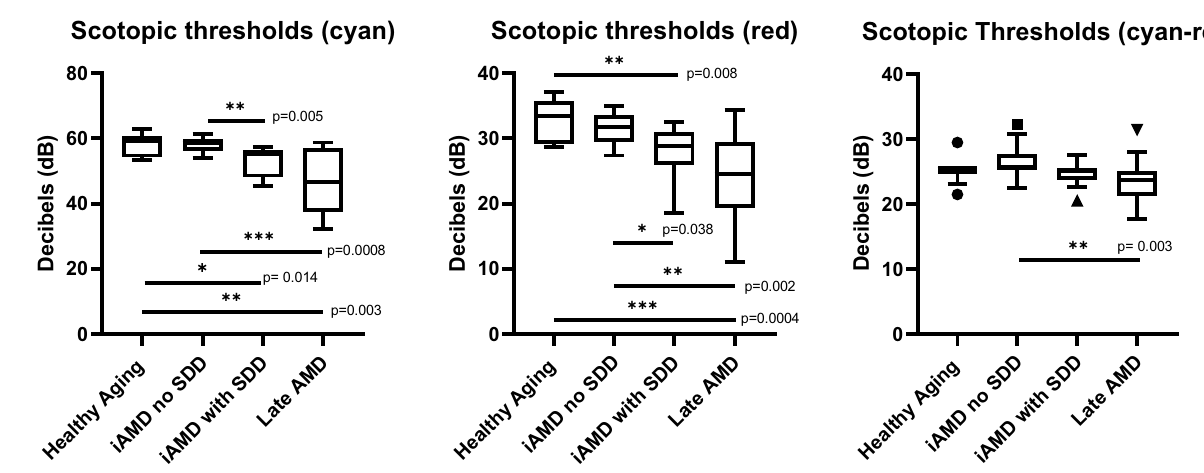
Figure 4. Boxplots for scotopic thresholds for cyan, red and difference between the two showing distribution of data across graded AMD severities. Black circles, squares and triangles show outliers (where data exceeds distance from the median by 1.5 times the interquartile range). Only significant differences between groups (P < 0.05) are